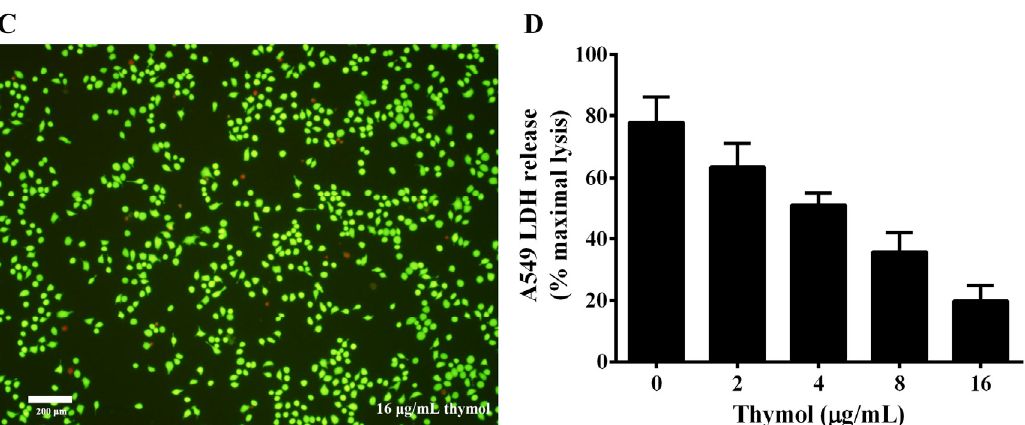
Figure 6. Thymol protects A549 cells against aerolysin ‐ mediated cell injury. For live/dead assay, cells were stained with a LIVE/DEAD Viability/Cytotoxicity Kit and images were captured by a fluorescence microscope. A fluorescent ‐ red dye stained dead cells, while a fluorescent ‐ green dye stained live cells. For lactate dehydrogenase (LDH) assays, LDH release was detected by a Cytotoxicity Detection Kit. A , untreated cells; B , cells treated with bacterial supernatant without thymol; C , cells treated with supernatant of A. hydrophila co ‐ cultured with 16 μ g/mL thymol; D , LDH release of A549 cells when treated with supernatants co ‐ cultured with indicated concentrations of thymol. All data are presented as mean value ± SD of three independent assays. *, p < 0.05 and **, p < 0.01 when compared with the drug ‐ free group.